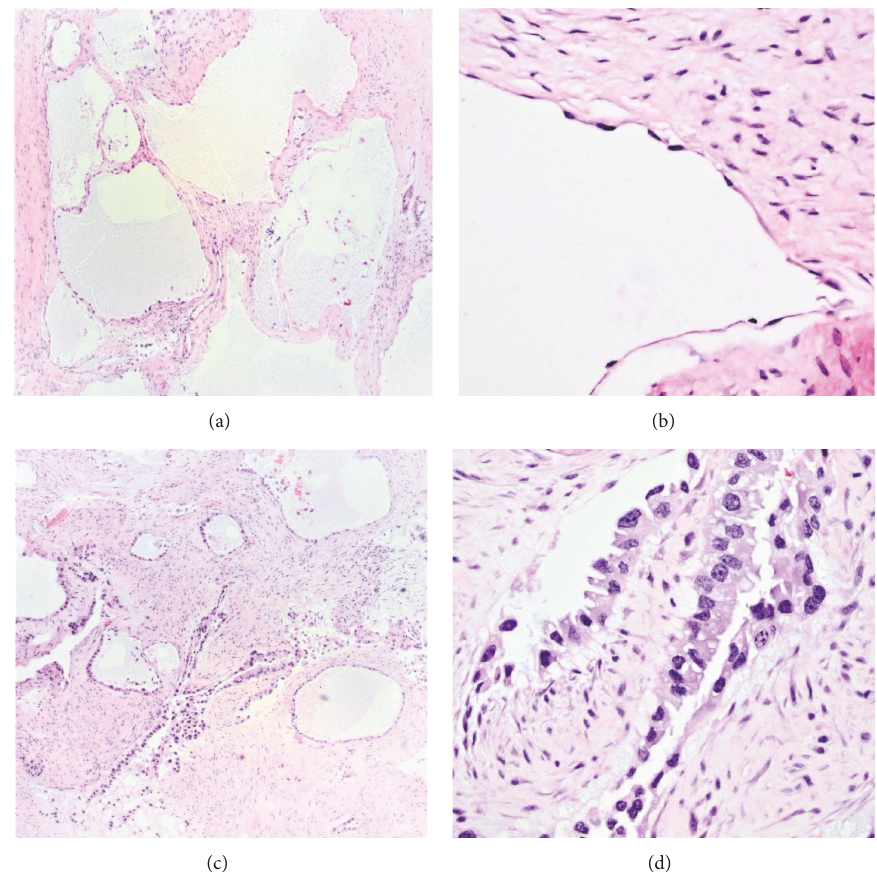
Figure 2: Histologic images of the tumor. (a) Multicystic bland appearance of the tumor, as seen on frozen section (H&E stain, X40). (b) Highermagnificationof cystic spaces lined by bland-appearing, flattenedcells (H&E stain, X200).(c)In otherareas the tumor shows irregular infiltratingglandswithfibrousstroma.(d)Highlyatypicalcells,withhobnailmorphologyandprominentnucleoli,liningtheinfiltratingtumor (H&E stain, X400).